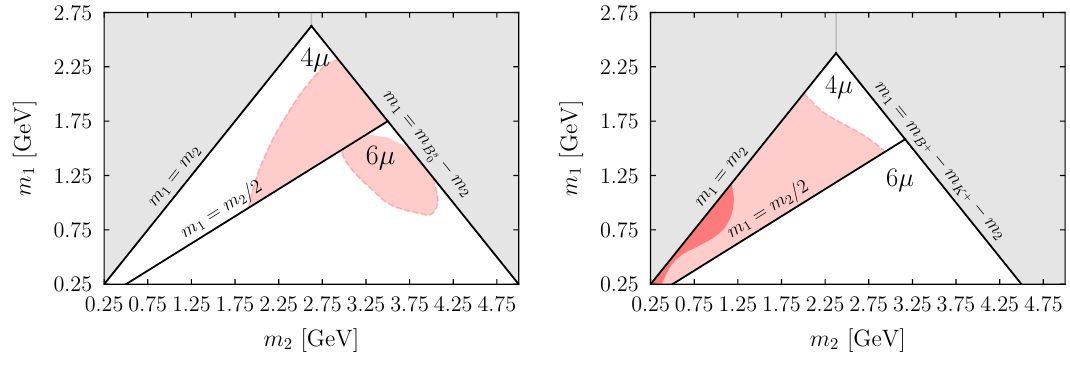
Figure 6 . Same as figure 5 but considering τ 1 = 10 ns. This time only the upper limits derived in section 3 from T-tracks are